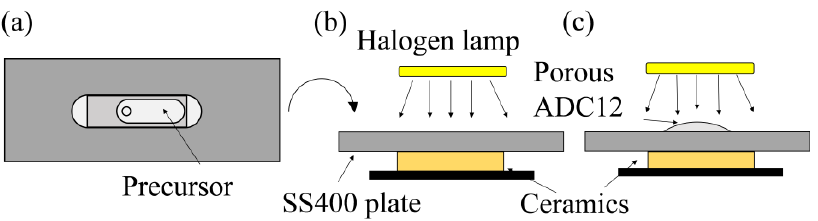
Figure 5. Setup for optical heating of precursor. ( a ) Precursor. ( b ) Beginning of heating. ( c ) Foaming.